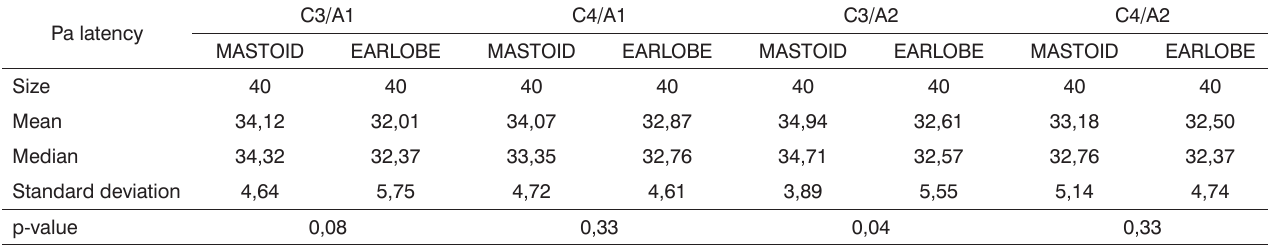
Table 4. Comparing Pa wave latencies in MLEAP C3/A1, C4/A1, C3/A2, C4/A2 modes between the mastoid and earlobe.